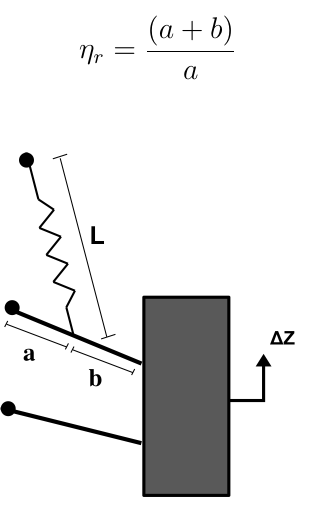
Figure 5. Suspension